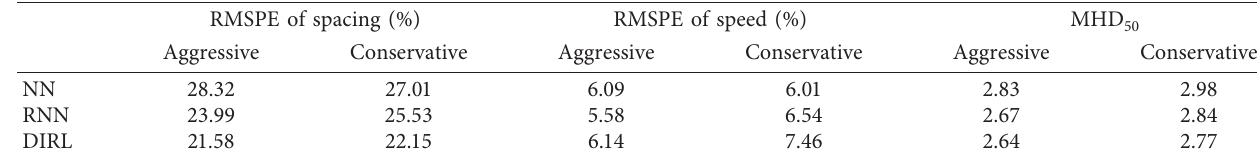
Table 4: The average performance of the models on the test